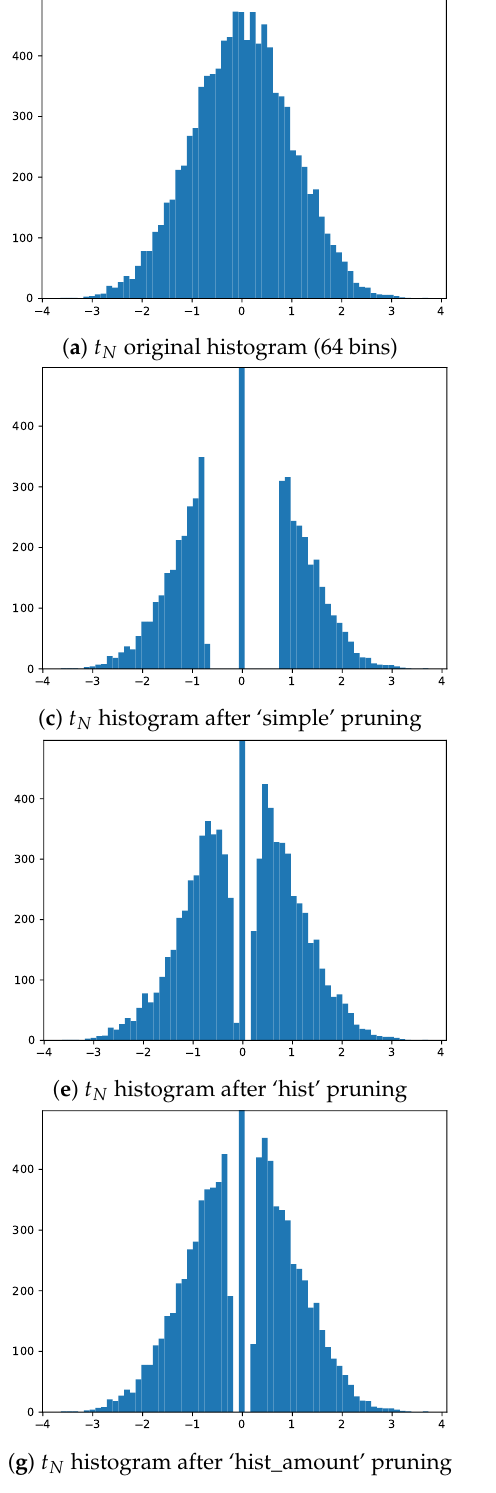
Figure A2. Application of different pruning methods for two tensors: t N —sampled from normal distribution, and t U —sampled from uniform distribution and scaled to ( − 1,1) range. The tensors length was 10 4 . For each method, the pruning fraction =